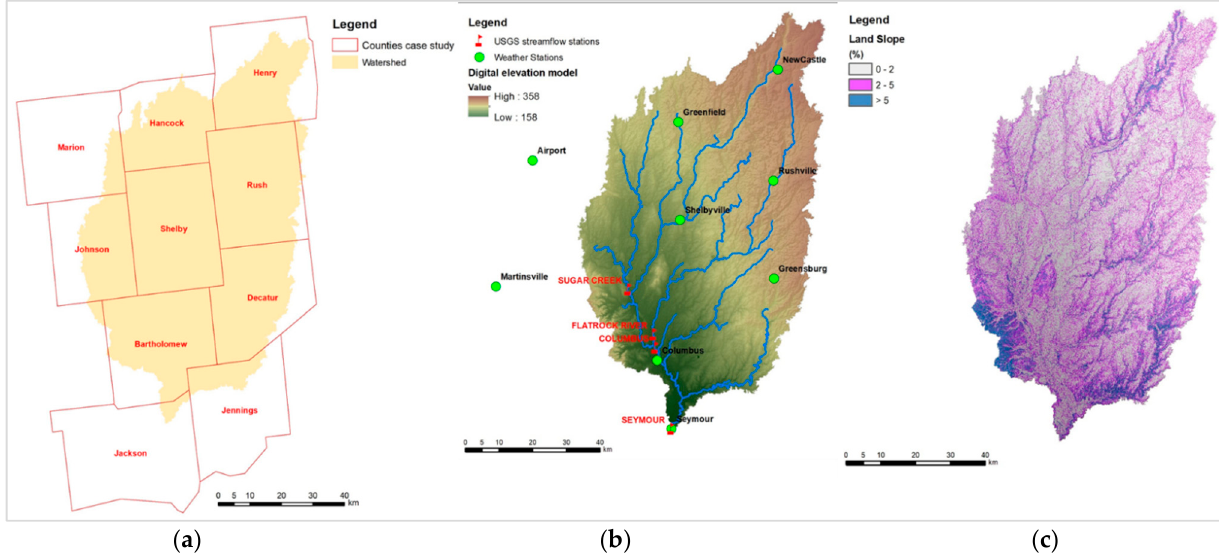
Figure 1. Study area with counties delineation ( a ), digital elevation model with weather and streamflow stations ( b ), slope distribution ( c ).